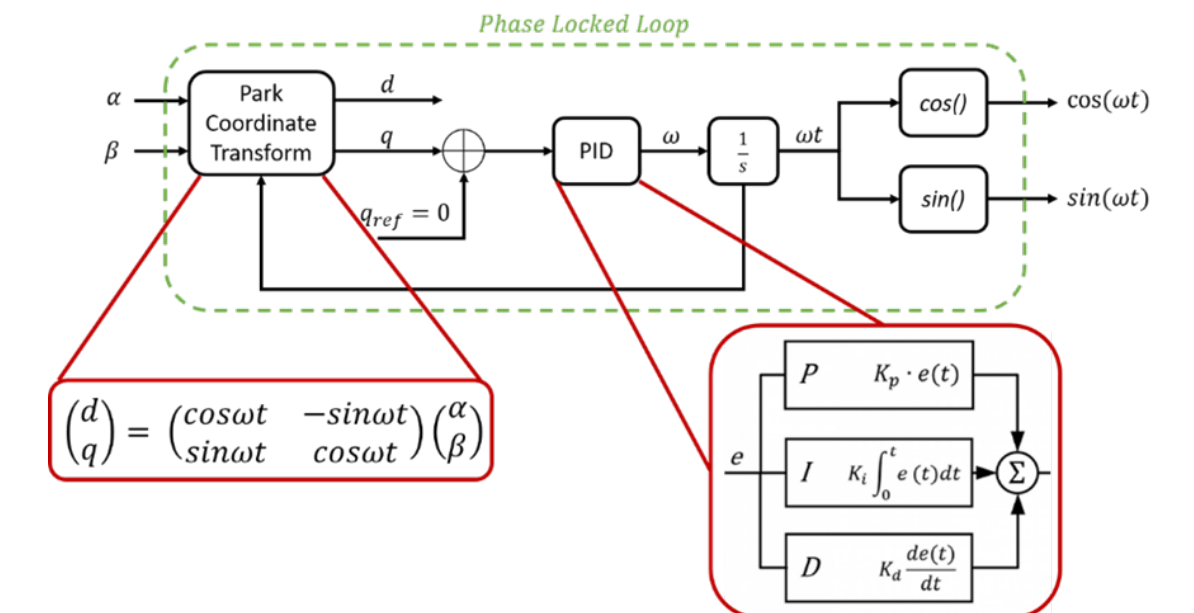
Figure 5. Block diagram representation of the Phase-Locked-Loop.